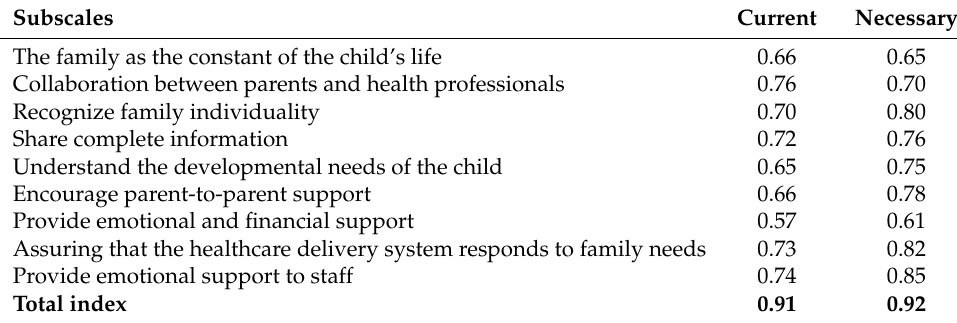
Table 2. Cronbach’s Coefficient Alpha of the FCCQ-R@it-NICU.